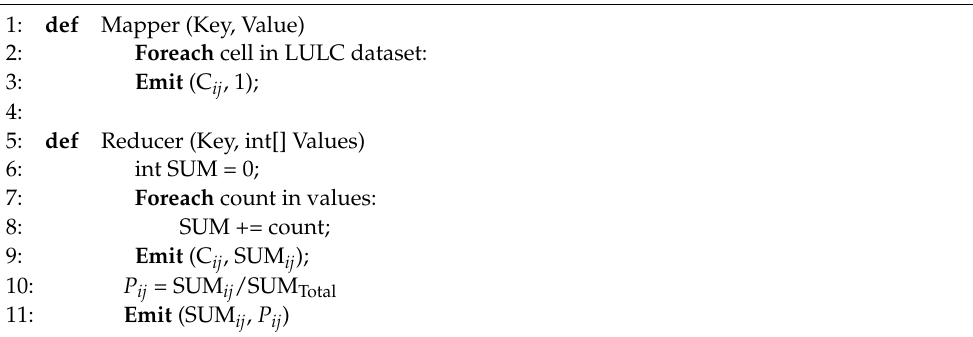
Algorithm 1 Distributed calculating probability matrix using Apache